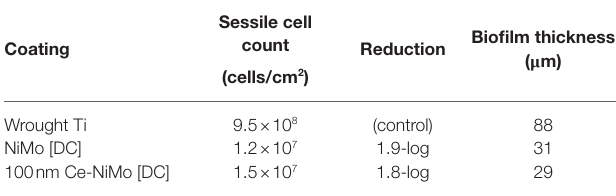
TABLE 4 | Algal sessile cell counts after 21-d aerobic incubation.